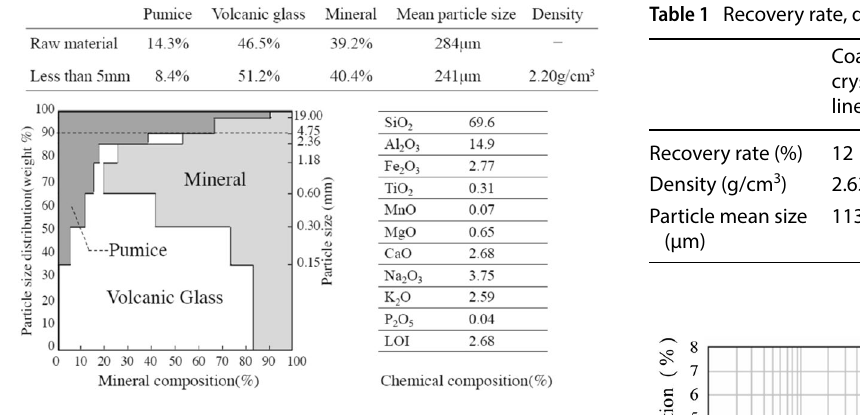
Fig. 4 Mineral composition of particle size fractions and chemical composition of Ito-shirasu